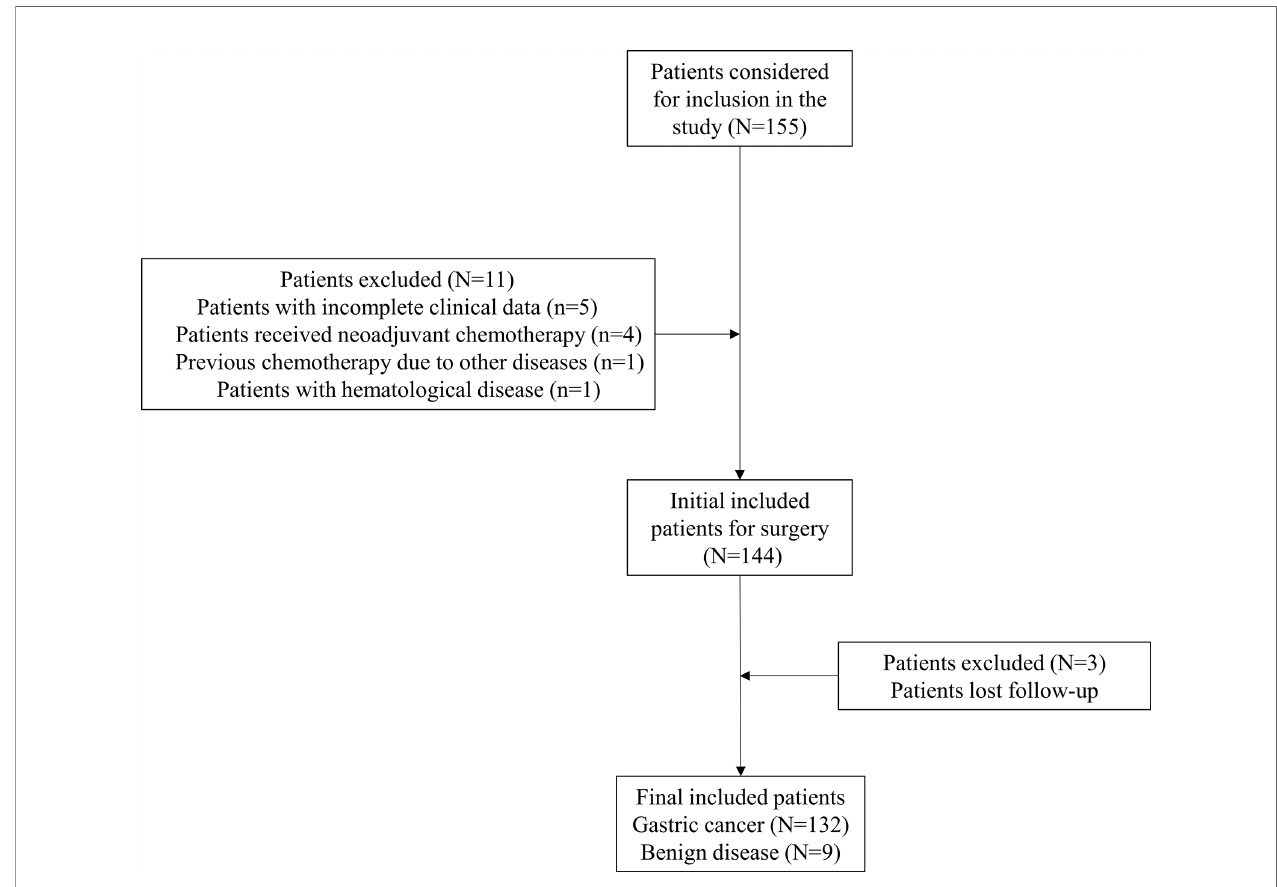
FIGURE 1 | Flowchart of included